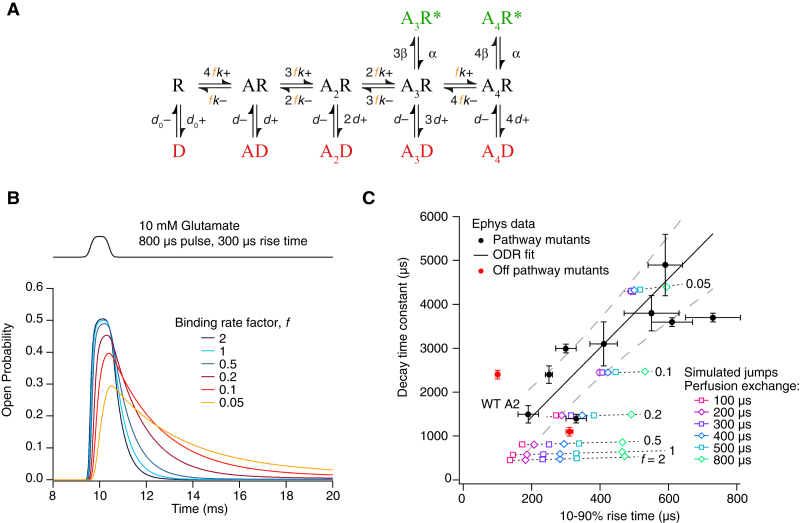
Kinetic Modeling of AMPA Receptor Currents Activated by Glutamate Recapitulates the Effect of Slowed Binding Reactions on Receptor Activation and Deactivation(A) Kinetic model constructed according to principles outlined in previous studies of GluA2 kinetics (Robert et al., 2005). Four glutamate-binding sites, two open states (green, ∗), and five desensitized states (red) are included. Low conductance open states and connections between desensitized states were omitted for simplicity. For each simulation, the association and dissociation rates were multiplied by a common factor, f, to represent the effects of mutants to slow binding rates through disruption of glutamate binding pathways. The rate constants were as follows: beta = 5,000 s–1, alpha = 3,000 s–1, k+ = 5 × 106 M–1 s–1, k– = 10,000 s–1, d+ = 250 s–1, d– = 60 s–1, d0+ = 1 s–1, d0– = 9 s–1. The conductance of the open state A4R∗ was set at twice that of A3R∗.(B) Example simulated currents (normalized to the maximum possible response) for a realistic concentration jump of 800 μs with rise time of 300 μs, using the model in (A). Six color-coded current profiles generated using the RCJ scripts (see STAR Methods) are shown, with the binding rate factor ranging from 2 to 0.05. Note that deactivation is more strongly affected than activation (because efficacy for channel opening is >1). Also, for fast binding reactions, the rise time is faster than the solution exchange.(C) Kinetic measurements from GluA2 mutants and WT (black circles, WT GluA2 marked) were well described by a linear fit with slope of ∼8 with intercept close to the origin. 95% confidence intervals for the line are shown as gray dashed curves. Uncertainties in both abscissa and ordinate were used for the fit (ODR = 2 in Igor 7). The reduced chi-square value for this fit is ∼6, meaning that the linear description of the data is, at best, approximate. Off-pathway control mutants (red circles) lie away from this curve. Data from simulations with different rise times for the glutamate pulse are plotted as open symbols, with the relevant f value for each group of simulations indicated with a dotted line. The colors of these symbols relates to the simulated 10%–90% solution exchange time seen by receptors. All solution exchange rates predict the similar steep, approximately linear relations between activation time (10%–90%) and decay time constant. The simulated kinetics span a similar range to the electrophysiological recordings of pathway-disruption mutants. The best agreement between simulation and experiment comes from solution exchange times at an intact patch in the physically plausible range of 200–400 μs.